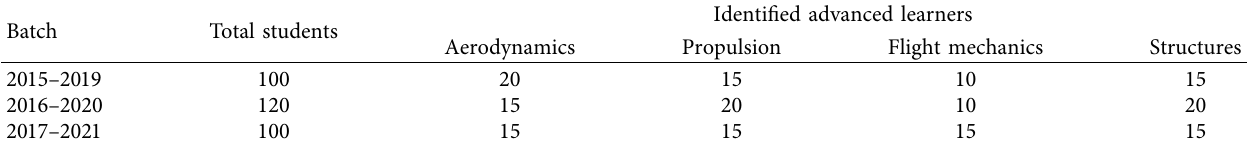
Table 2: Classification of advanced